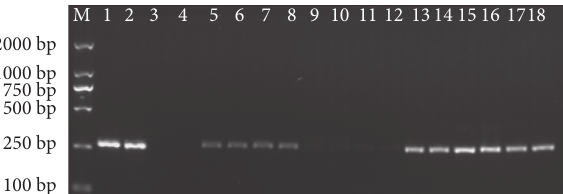
Figure 11: PCR detection of 16S–23S of C. sakazakii in Flammulina velutipes collected from 7 traditional retail markets. M , DNA marker D (100 ∼ 2000bp); lanes 1-2, positive control; lane 3, negative control; lane 4, blank control; and lanes 5–18, PCR results of 7 samples, respectively; each sample was tested twice.